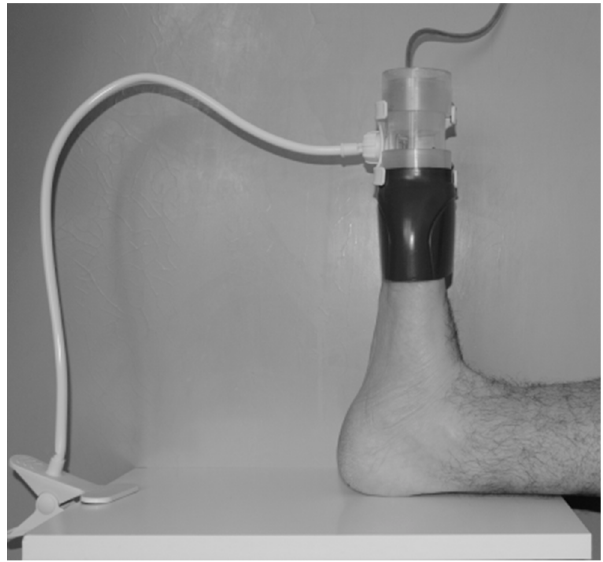
Figure 6. Exposure of affected toenails.